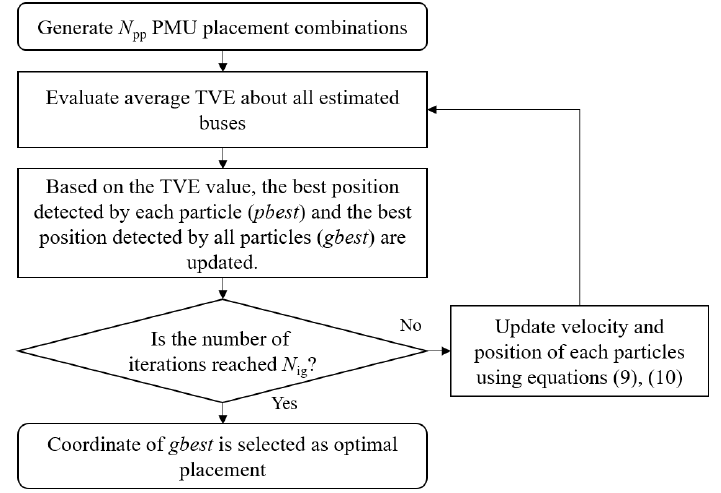
Figure 3. Flowchart of